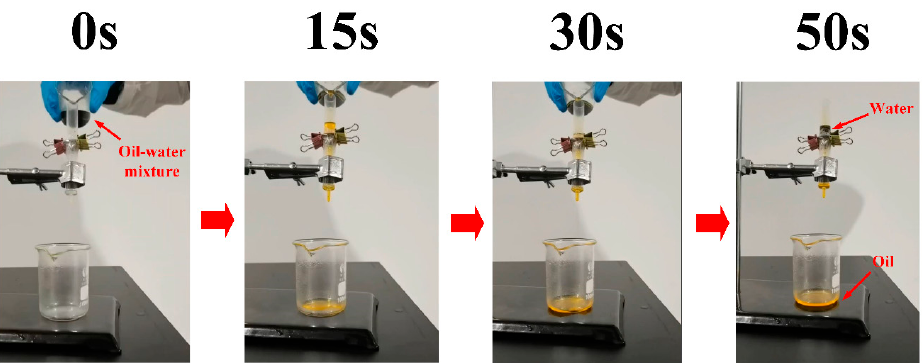
Figure 11. Continuous water/oil separation process using the laser-heat treated Cu foam with the laser processing parameters of power 12.0 W, scanning speed of 200 mm/s and line spacing of 20 μ m.